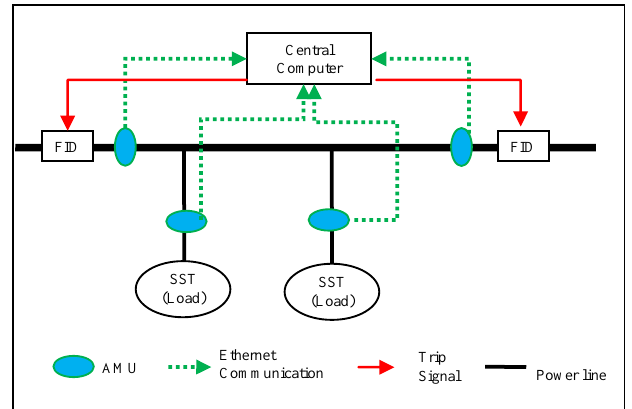
Figure 2. Connection of the protection system within a